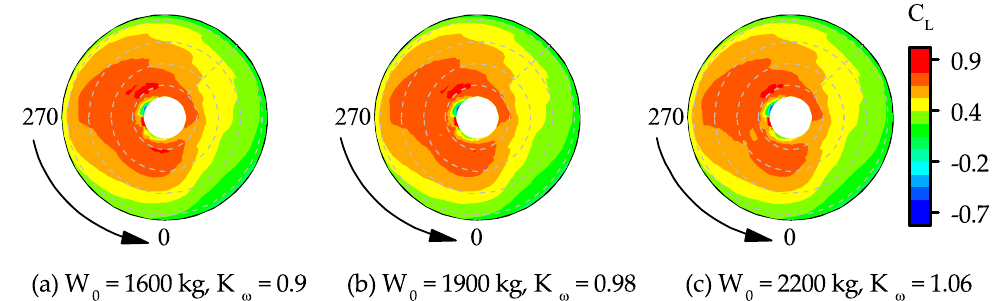
Figure 7. µ = 0.15, lift coefficient, C L , with rotor